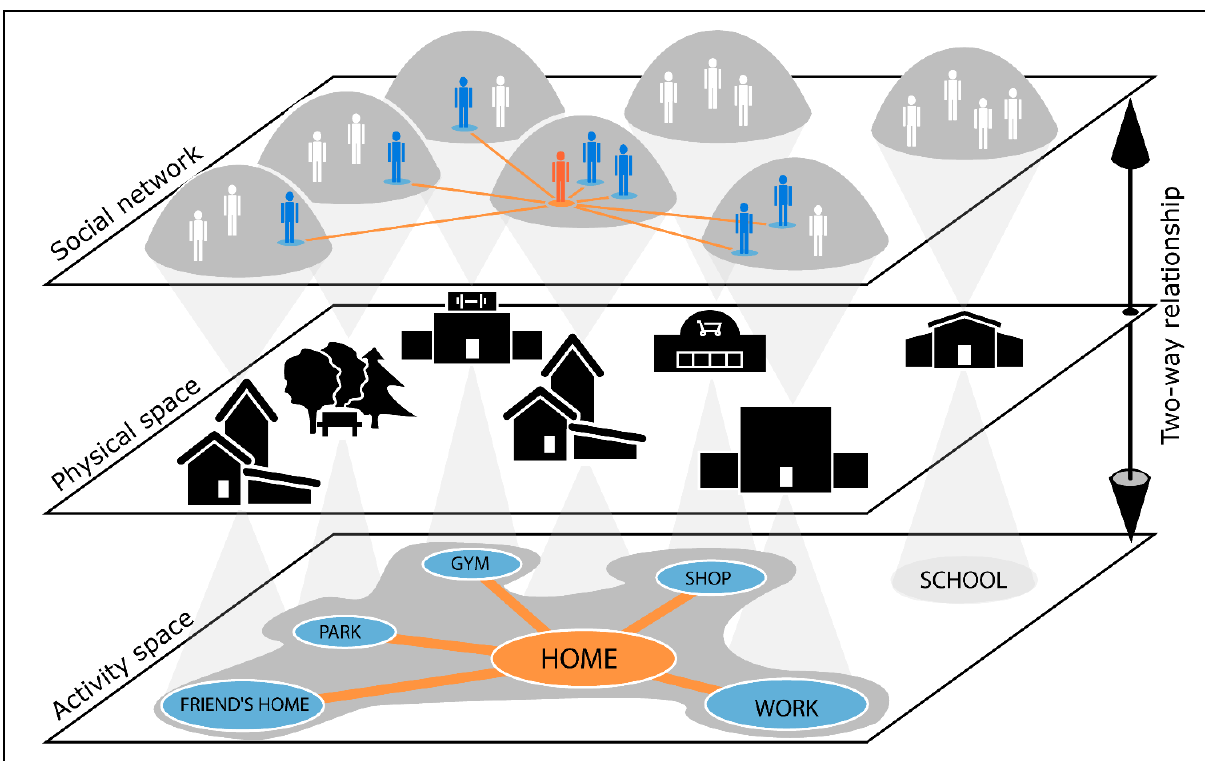
Figure 1. Two-way relationship between an individual’s social network and activity space. between areas with similar cultural and linguistic compo- sition (Expert, Evans, Blondel, & Lambiotte, 2011; Ratti et al., 2010). Ethnic minorities tend to visit regions where the concentrations of those minorities are higher (Silm & Ahas,